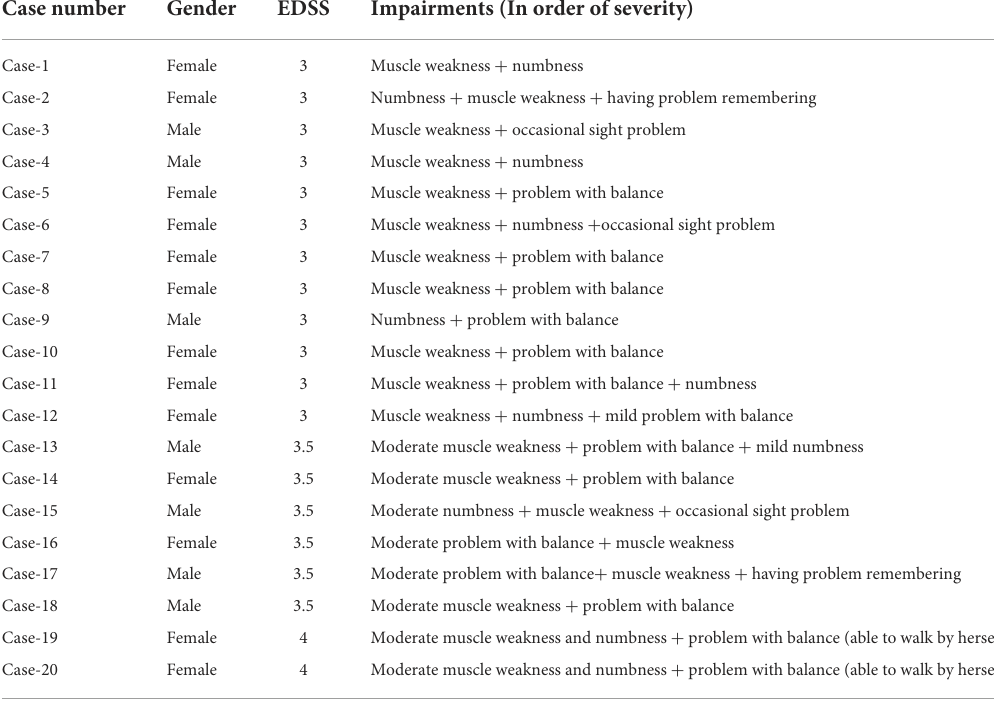
TABLE 2 The information related to the condition of RRMS